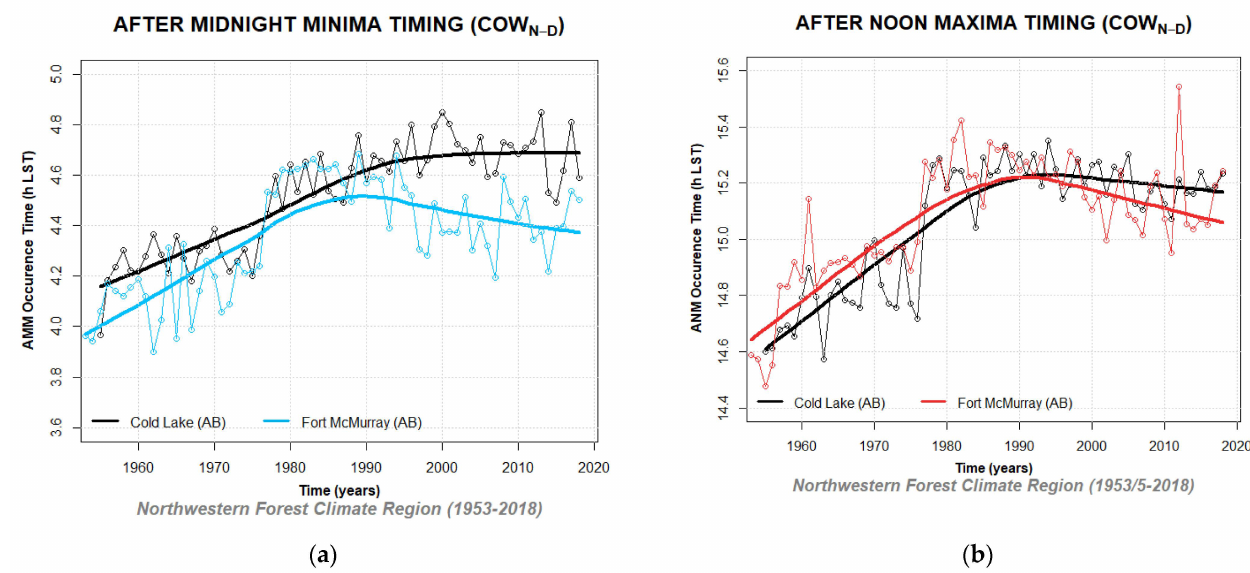
Figure A24. Annually averaged After Midnight Minima ( a ) and After Noon Maxima timing shifts ( b ) and LOESS fit curves for Cold Lake (AB) and Ft McMurray (BC) temperature time series, Northwestern Forest climate region.